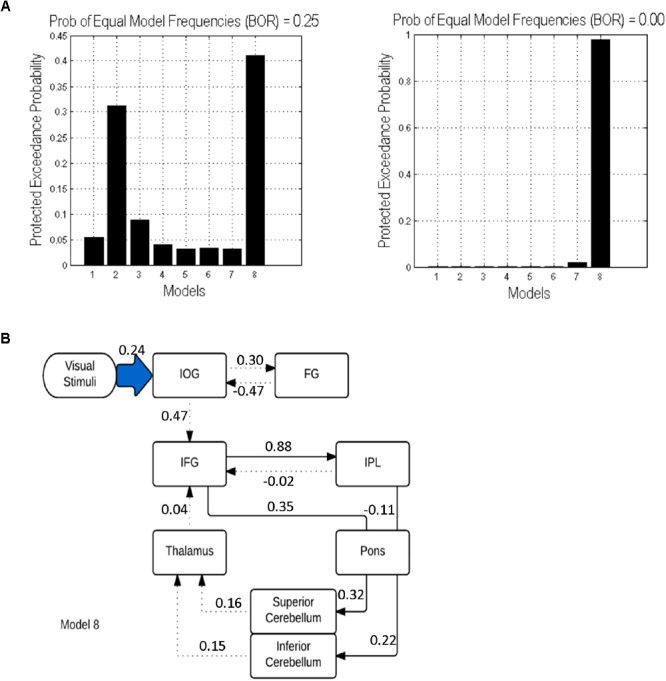
DCM results: (A) Protected exceedance probability for 8 specified models uninformed (left) and informed (right) by tractography results. (B) The optimal model 8 informed by tractography results. Dotted lines indicate intrinsic effects, continuous lines represent the modulatory effects. Driving input is indicated by the blue shaded arrow.